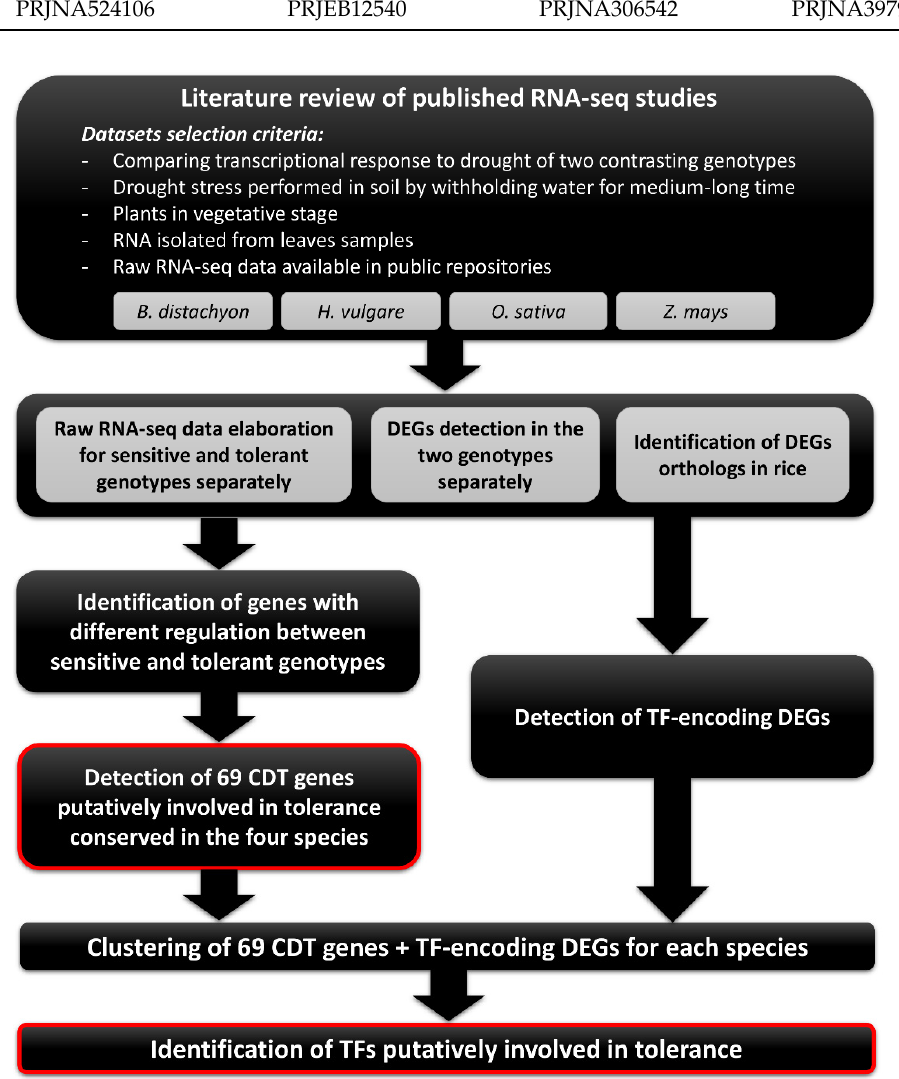
Figure 1. Overall workflow used in this study for the identification of genes putatively involved in drought tolerance in cereal crops, as well as upstream transcription factors involved in their regu- lation. CDT genes: Conserved Drought-tolerance Related genes.